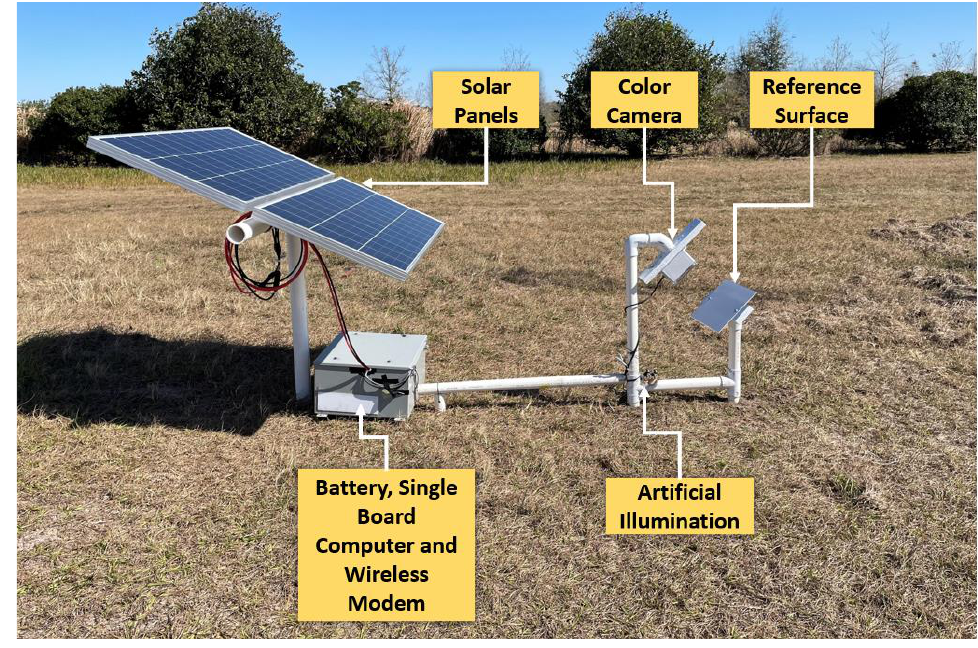
Figure 2. System to monitor a reference surface using an RGB camera at UF GCREC, Wimauma.